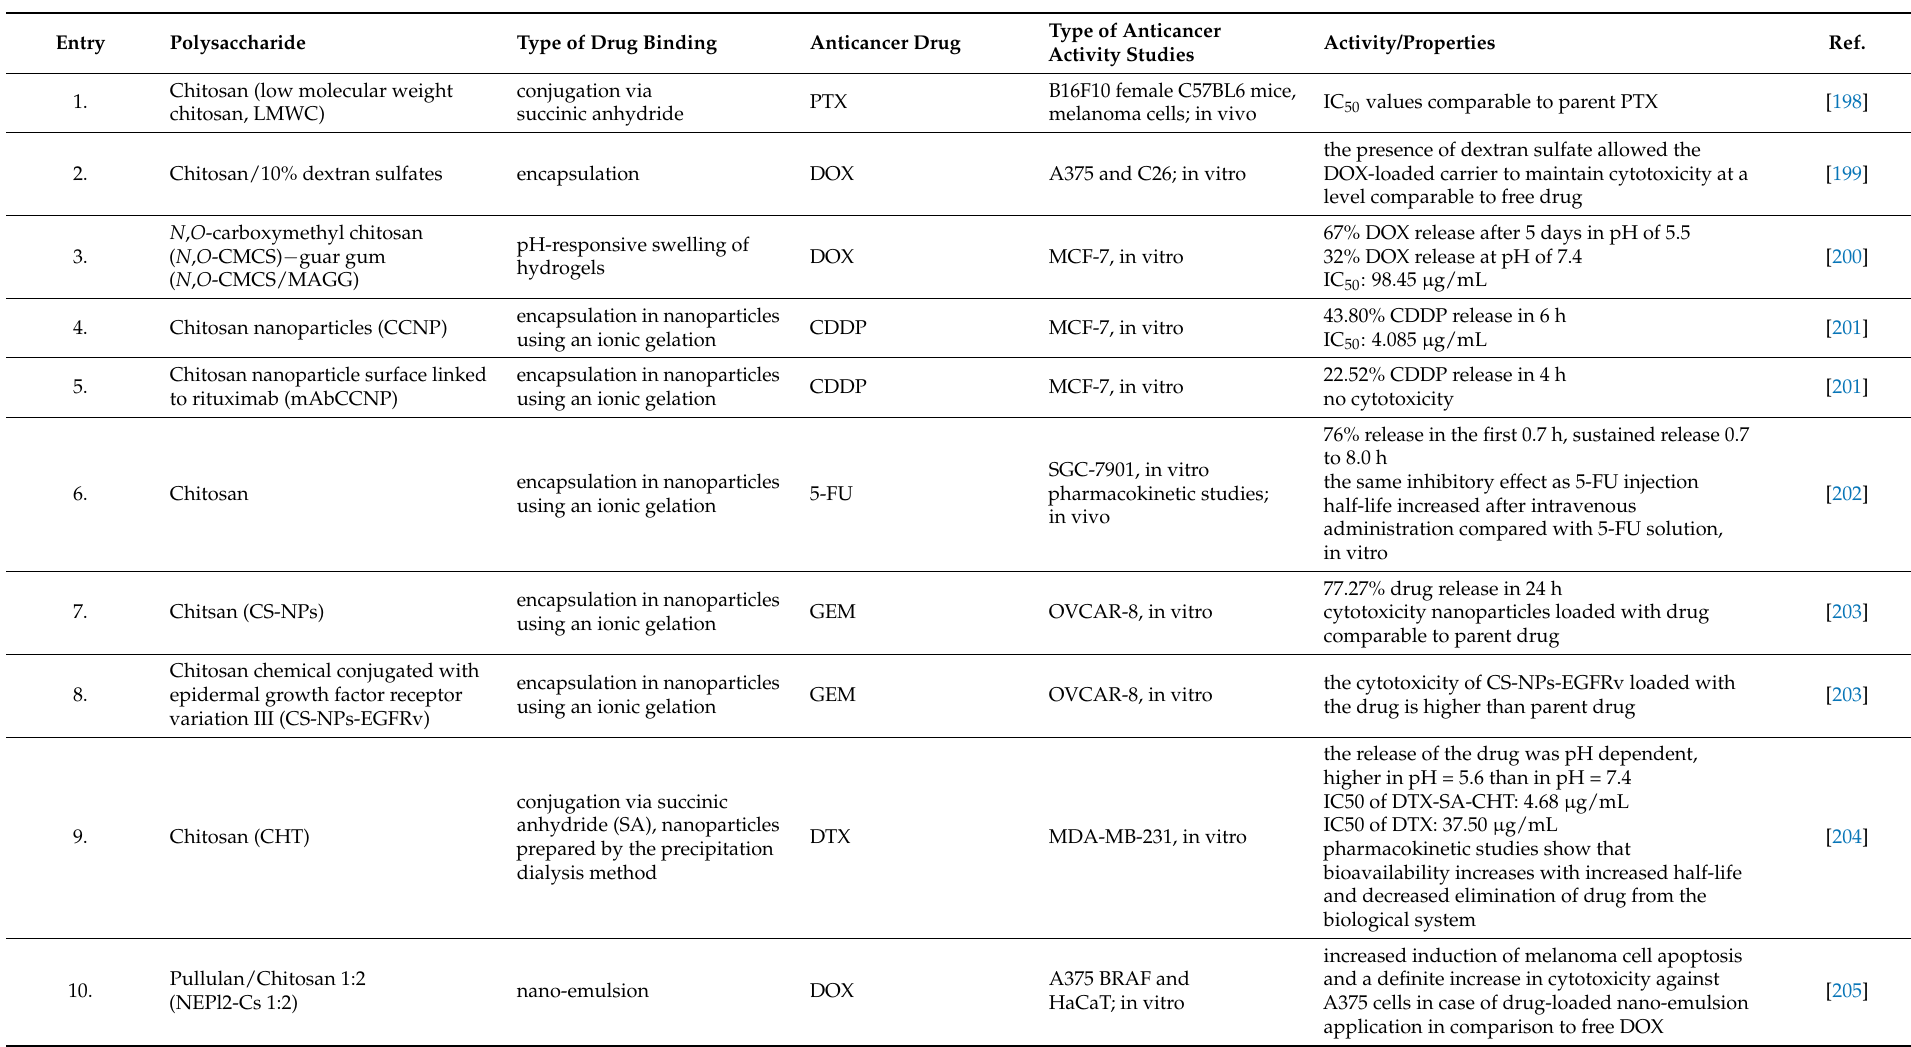
Table 3. Polysaccharide-based carriers for anticancer